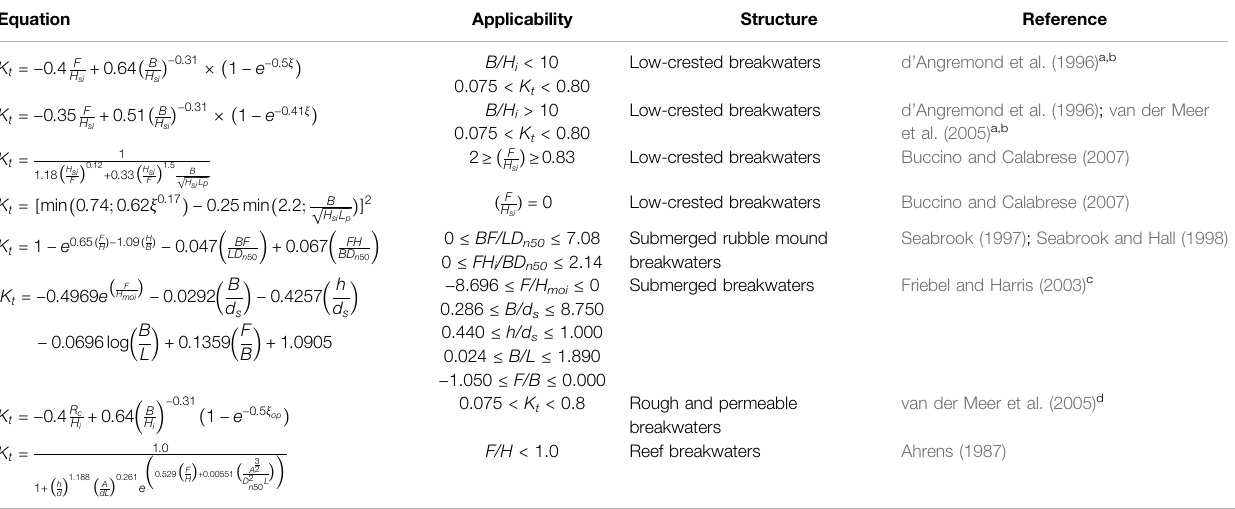
TABLE 1 | Empirical equations to describe the transmission coef fi cient for waves over low-crested or submerged breakwater structures and the ranges these equations are valid.